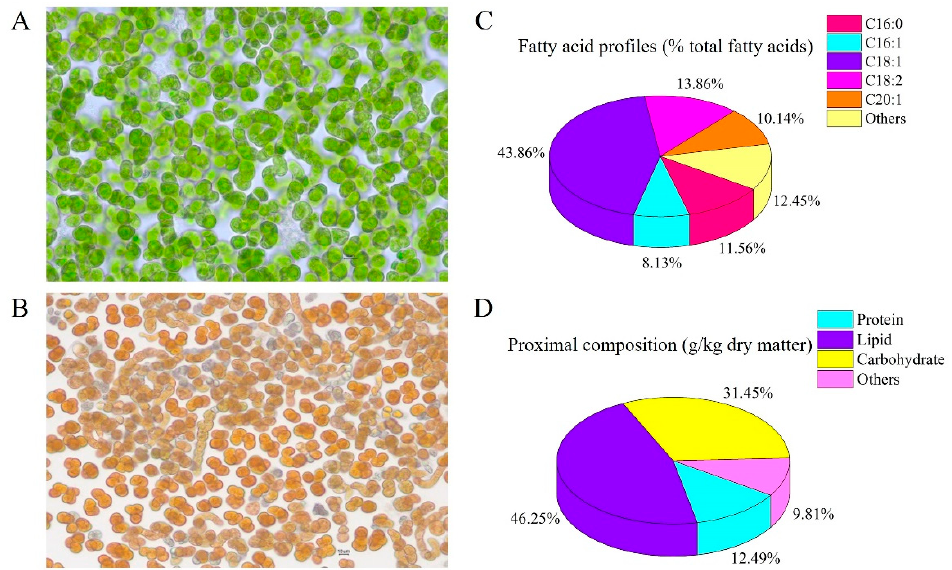
Figure 1. Cell morphology (( A ), vegetative cell; ( B ), pigment accumulation cell), fatty acid profiles (( C ), % total fatty acids) and proximal composition (( D ), g/kg dry matter) of Barranca yajiagengensis. Three isonitrogenous and isolipidic experimental diets were formulated to contain 0% (BY0), 1% (BY1), and 5% (BY5) B. yajiagengensis powders. The formula and nutrient levels of experimental diets were presented in Table 1. All ingredients were thoroughly ground using a grinder and then sifted through a 100 μ m sieve to obtain a uniform sam- ple. Based on the feed formula, all required ingredients were weighed and thoroughly mixed. Then, distilled water (300 g kg − 1 dry matter) was added to the mixture. The pre- pared mixtures were transferred into a puffing apparatus (Institute of Chemical Engineer- ing, South China University of Technology, Guangdong, China), and the final 2.5-mm- diameter puffed pellets were produced. The diets were dried in an air-conditioned room until the moisture level was below 10%, and then stored at − 20 °C. Table 1. Composition and nutrient levels of the experimental diets (% dry matter).